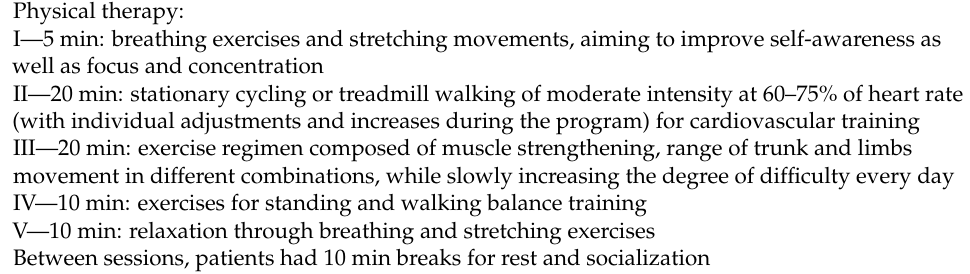
Table 2. Structure of the rehabilitation program